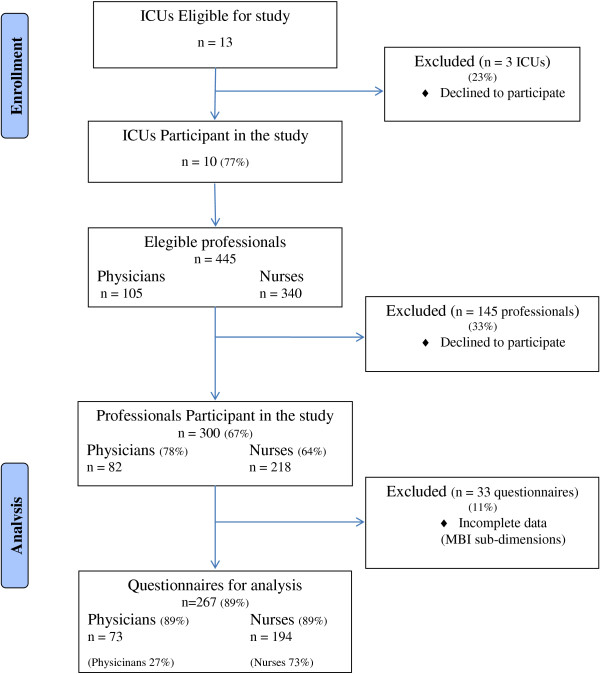
Study design. This flowchart describes the inclusion of professionals for eligible centers to arrive to the final study population (questionnaires considered for analysis). ICU: Intensive Care Unit.